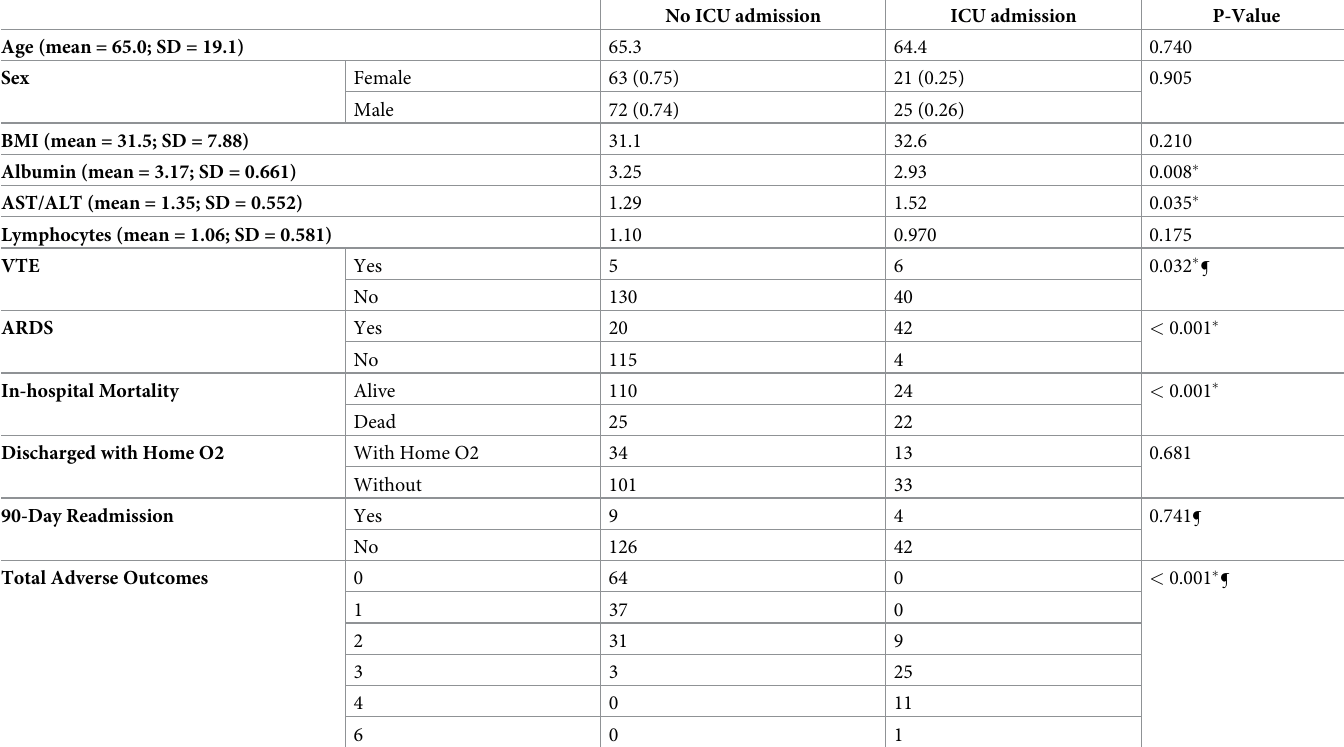
Table 2. Characteristics of the patient cohort with and without ICU admission.